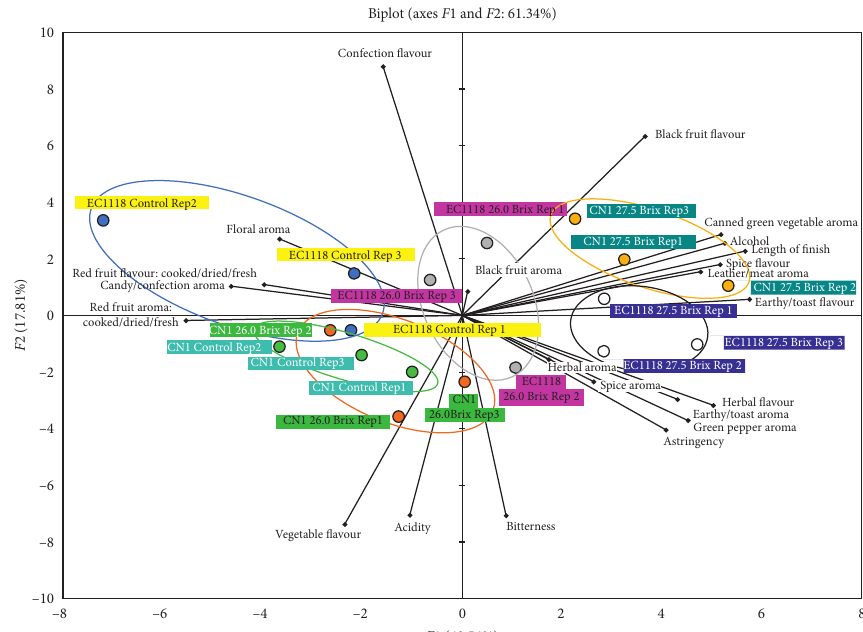
Figure 2: Principal components analysis biplot of descriptive analysis data for wines made from partially dehydrated grapes including winemaking replicates fermented with S. cerevisiae EC1118 and S. uvarum CN1 at different starting sugar concentrations (control (21.5 ° Brix), 26.0 ° Brix, and 27.5 °